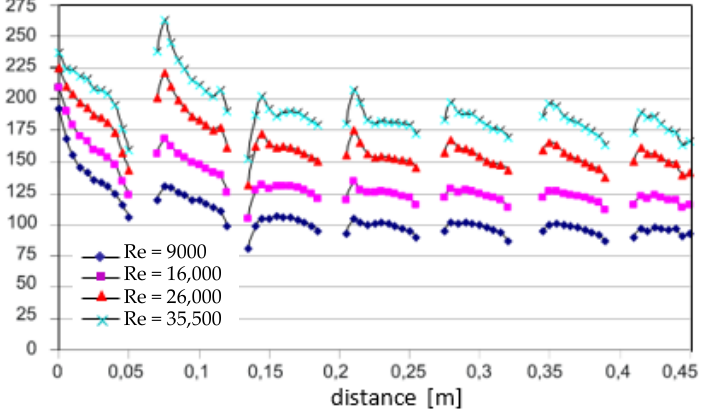
Figure 20. Local Nusselt number distribution for different Re numbers for a channel with slanted ribs on the bottom and the top surface of the channel (configuration_4).